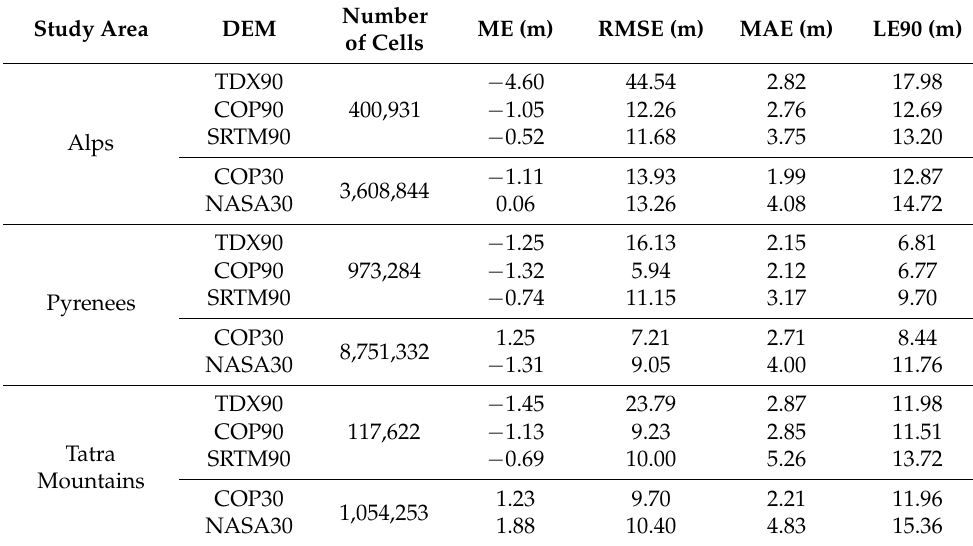
Table 1. Accuracy measures for TDX90, COP90, SRTM90, COP30, and NASA30 in the three study areas in comparison with the reference LiDAR